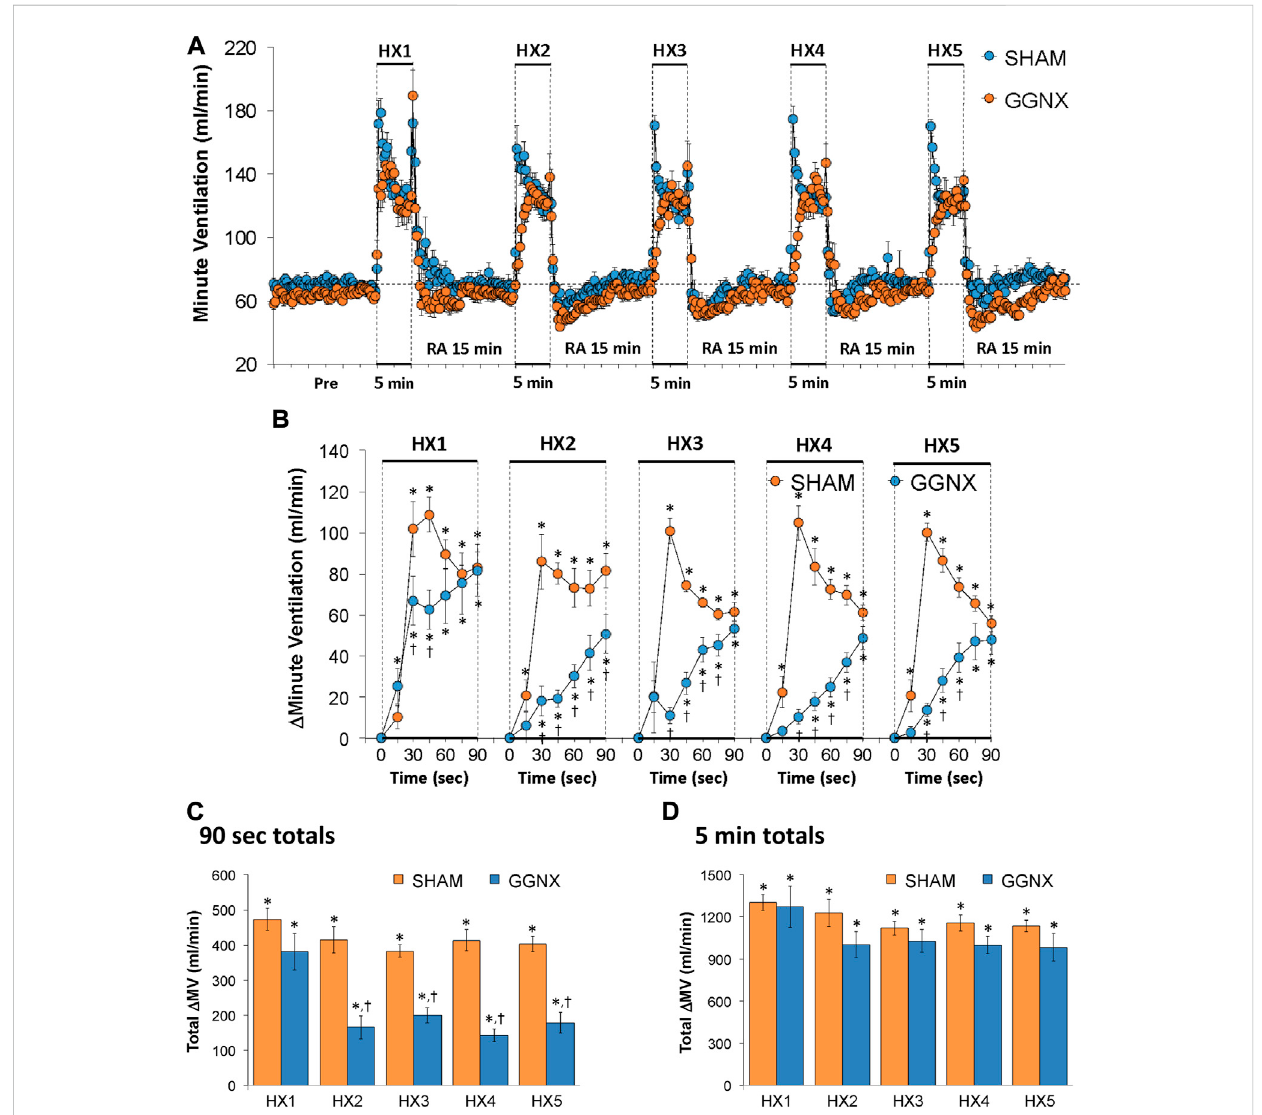
FIGURE 4 (A) Minute ventilation in sham-operated (SHAM) rats and in rats with bilateral ganglioglomerular nerve transection (GGNX) before (Pre) and during fi vehypoxic (HX, 10% O 2 , 90% N 2 )gas challenges, each separated by 15 min of room-air (RA). (B) Arithmeticchanges in minute ventilationduring the 90 s of HX gas challenge. (C) Total changes in minute ventilation during the fi rst 90 s of HX gas challenge. (D) Total changes in minute ventilation during the entire 5 min of HX gas challenge. The SHAM group had 10 rats. The GGNX group had 12 rats. The data are presented as mean ± SEM. * p < 0.05, signi fi cant response. † p < 0.05, GGNX rats versus SHAM